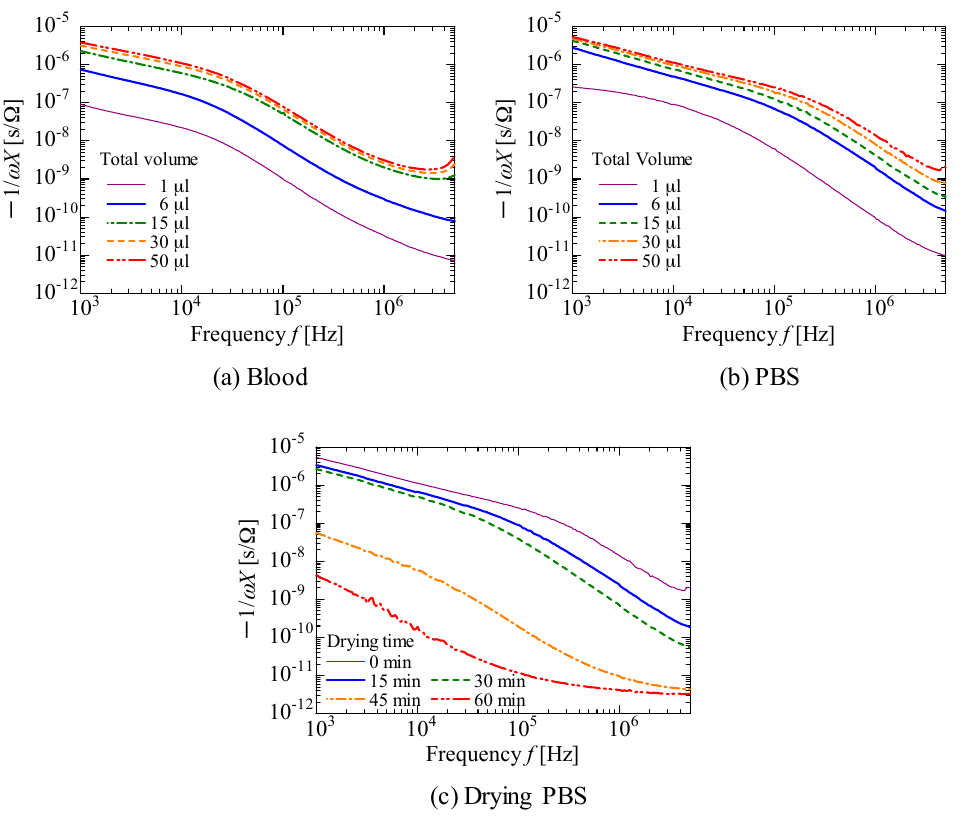
Figure 5. Sensor values of − 1/ ω X as a function of frequency f obtained when up to 50 µ L of ( a ) blood or ( b ) PBS was dropped on the sensor. The sensor, on which a total volume of 50 µ L of PBS was dropped, was dried at room temperature; spectral dependence on drying time is shown in ( c ).